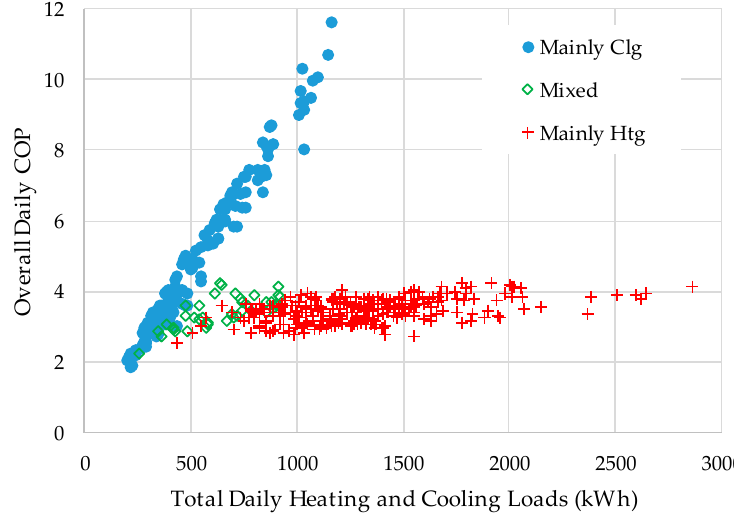
Figure 11. Overall daily COP vs. overall daily load.